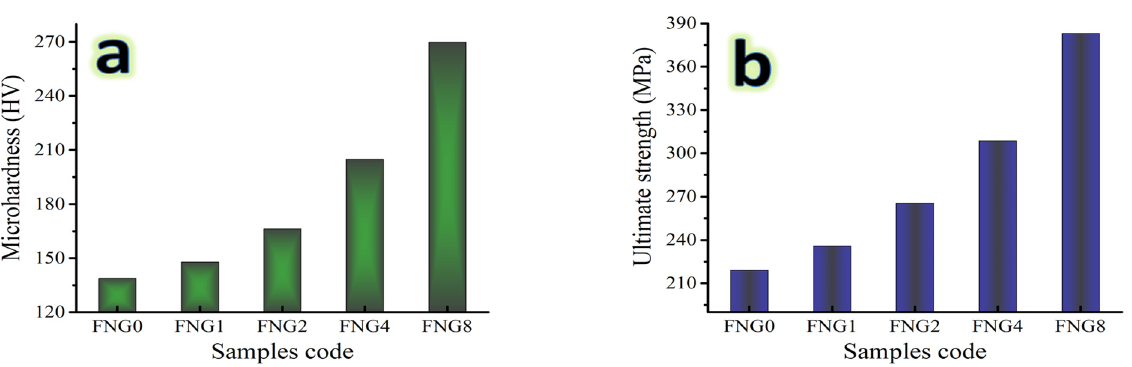
Figure 10. ( a ) Microhardness and ( b ) ultimate strength of sintered Fe–Cu alloy and its nanocomposites.